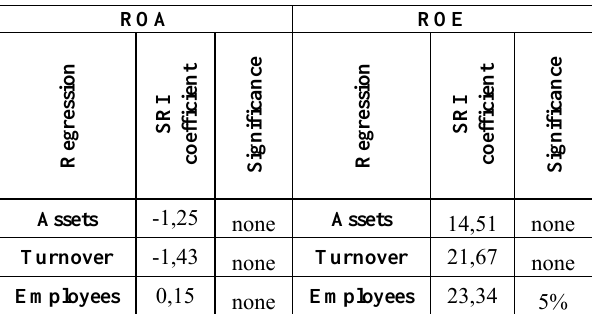
Table 4: Regression results following McWilliams &